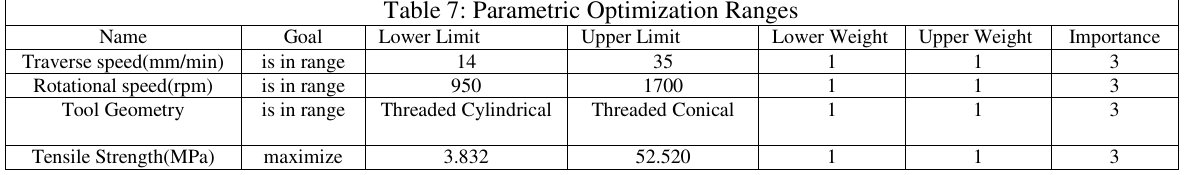
Table 7: Parametric Optimization